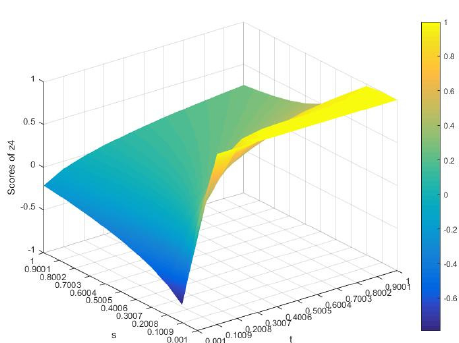
Figure 5. Score values of scheme 3.